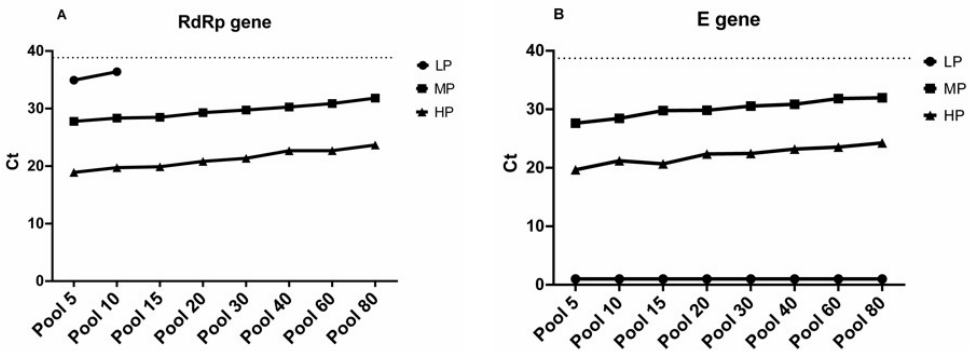
Figure 3. Comparative PCR results for RdRp ( A ) and E ( B ) genes in pools using high positive (HP), medium positive (MP), and low positive (LP) reference samples. Results are expressed as C t values. Dashed line represents the threshold for inconclusive results ( C t < 38).